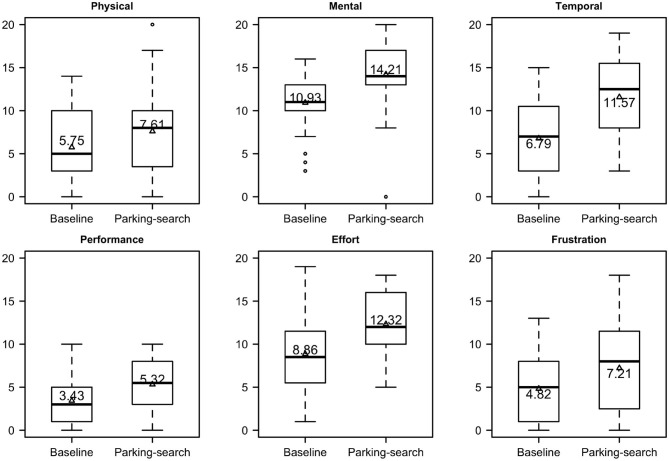
NASA TLX un-weighted ratings for each workload category and task condition.